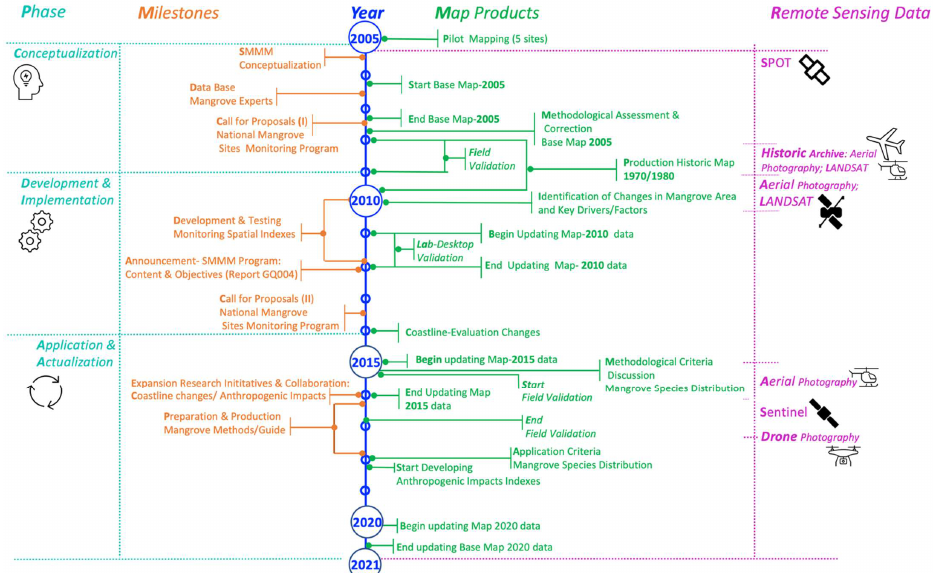
Figure 3. Different phases and milestones in the development of the Mexican Mangrove Monitoring System (Spanish acronym: SMMM) from 2005–2020 including the production of maps and analysis of remote sensing